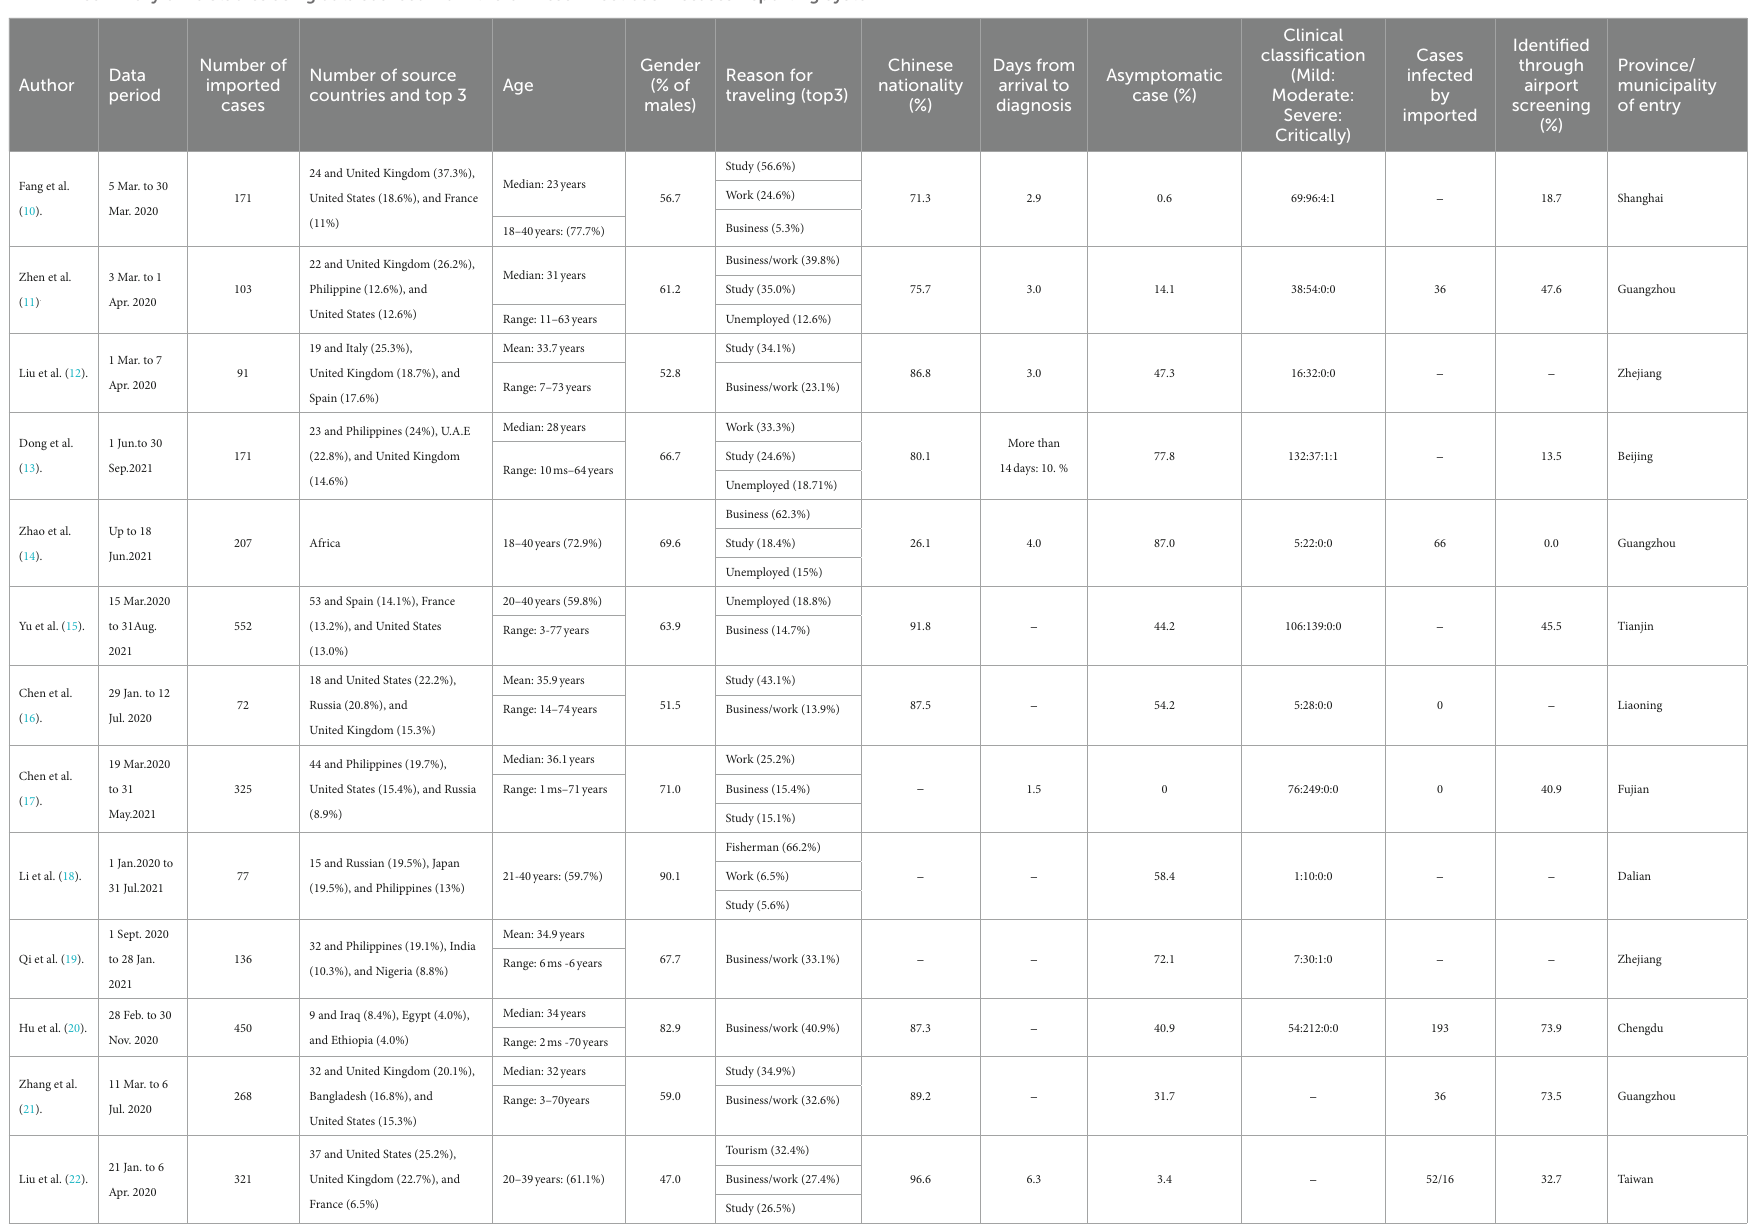
TABLE 1 Summary of 13 studies using data sourced from the Chinese Infectious Diseases Reporting